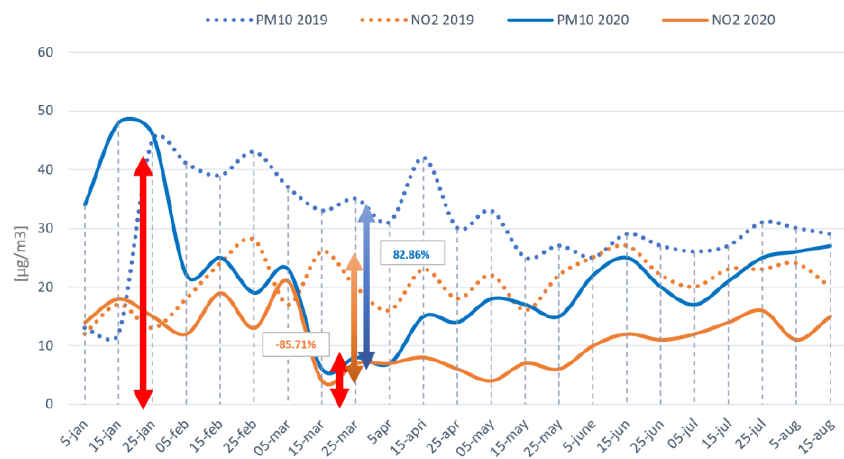
Figure 7. Chart of air pollutants in Prague from January to August of 2019 and 2020. Source: Own elaboration by data collected from AQICN [18].